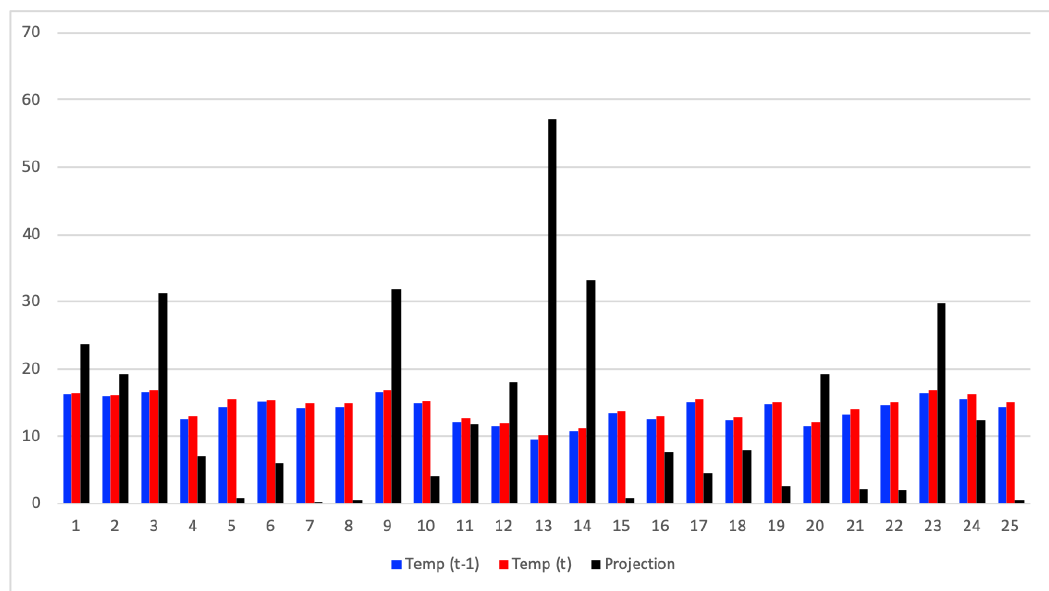
Figure 16. Temperature values obtained for previous and current time (t). Projection of current time temperature values on the sparsifying basis.